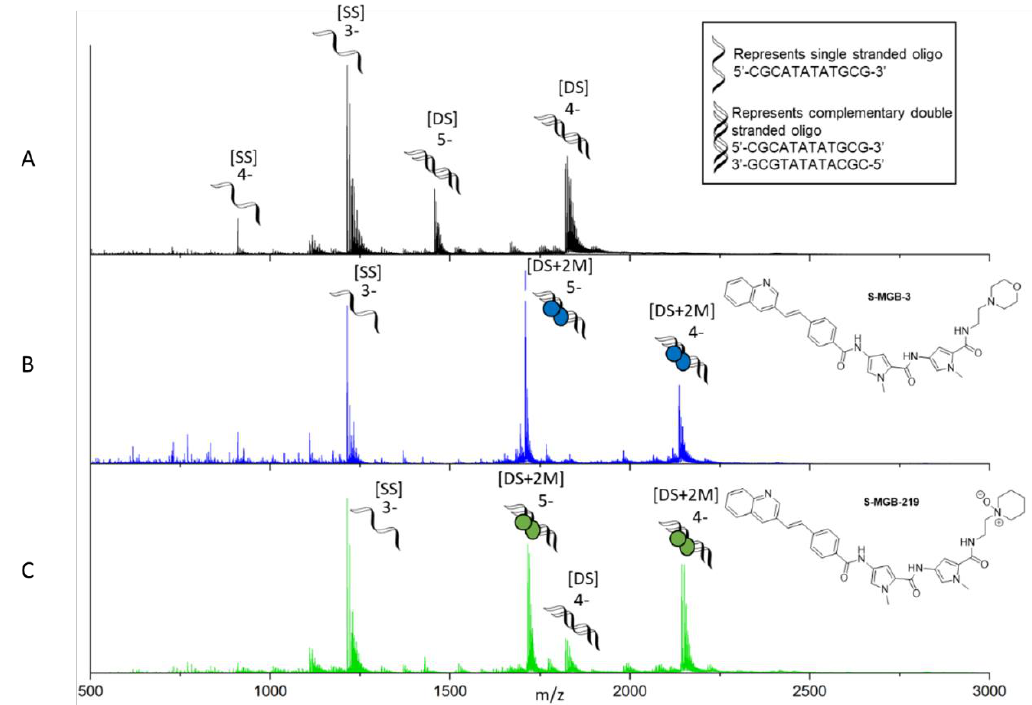
Figure 4. Characterisation of S-MGB-BP3 and S-MGB-219 binding to double-stranded DNA as a dimer via nMS. Spectra of DNA sequence 5′ -CGCATATATGCG- 3′ (9 μM DNA, 100 μM KCl and 1% DMSO) sprayed from ammonium acetate (150 mM, pH 7) in the ( A ) absence and ( B ) presence of 100 μM S -MGB-BP-3, or ( C ) of 100 μM S -MGB-219. ( A ) Single-stranded DNA (denoted by [SS]) is present in charge states 4- and 3-, and double-stranded DNA (denoted by [DS]) is present